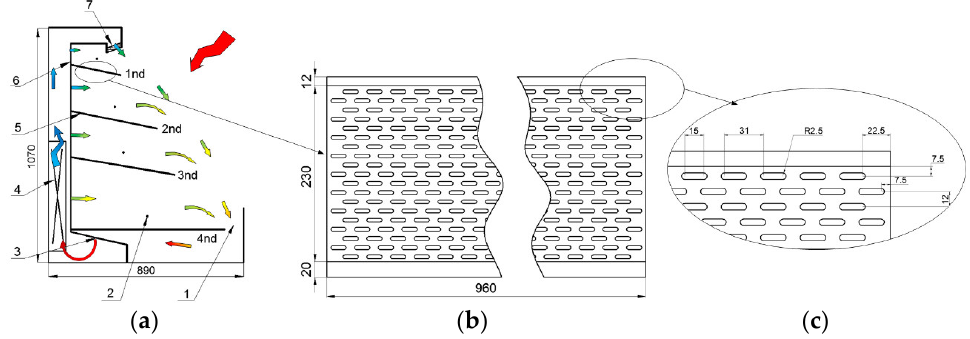
Figure 1. Display cabinet structure and shelf schematic diagram: ( a ) display cabinet structure draw- ing; ( b ) shelf structure diagram; ( c ) shelf local diagram. 1. Return air port; 2. Temperature and hu- midity sensor; 3. Fan; 4. Vaporator; 5. Shelf; 6. Backplane air outlet; 7. Wind curtain